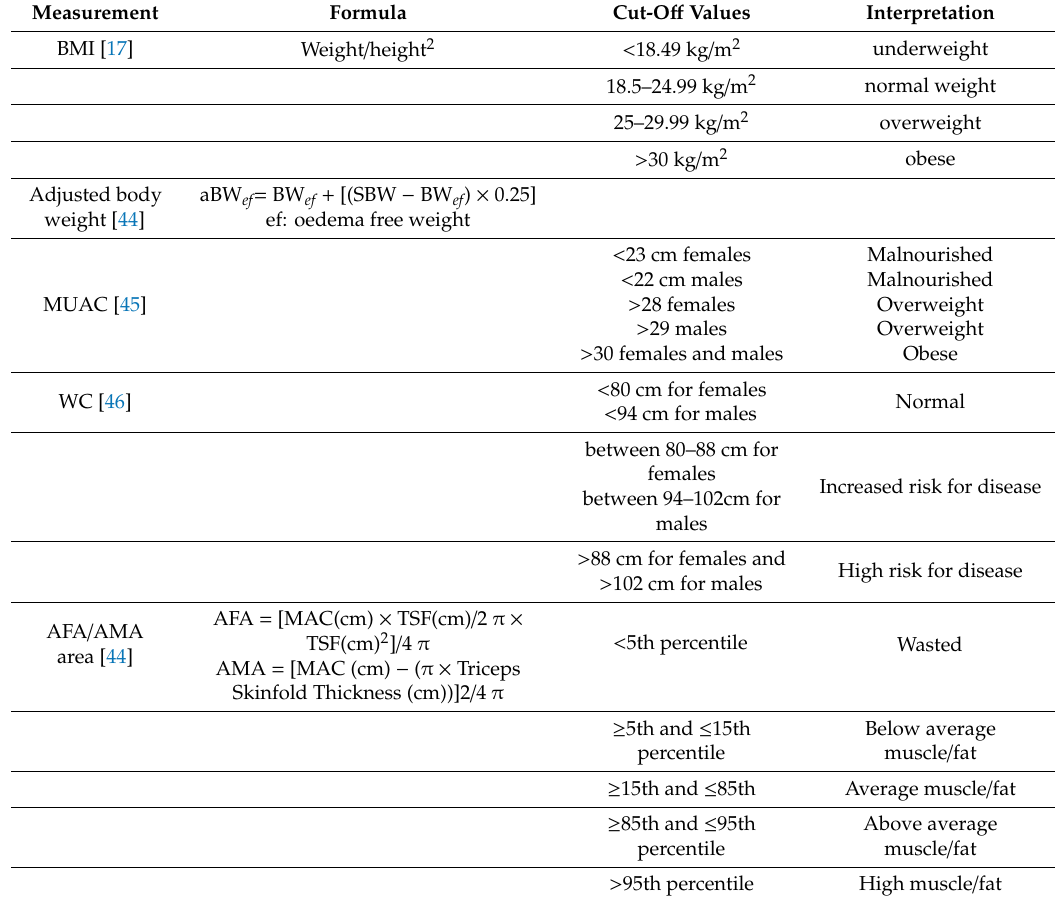
Table A1. Anthropometric Measurements and